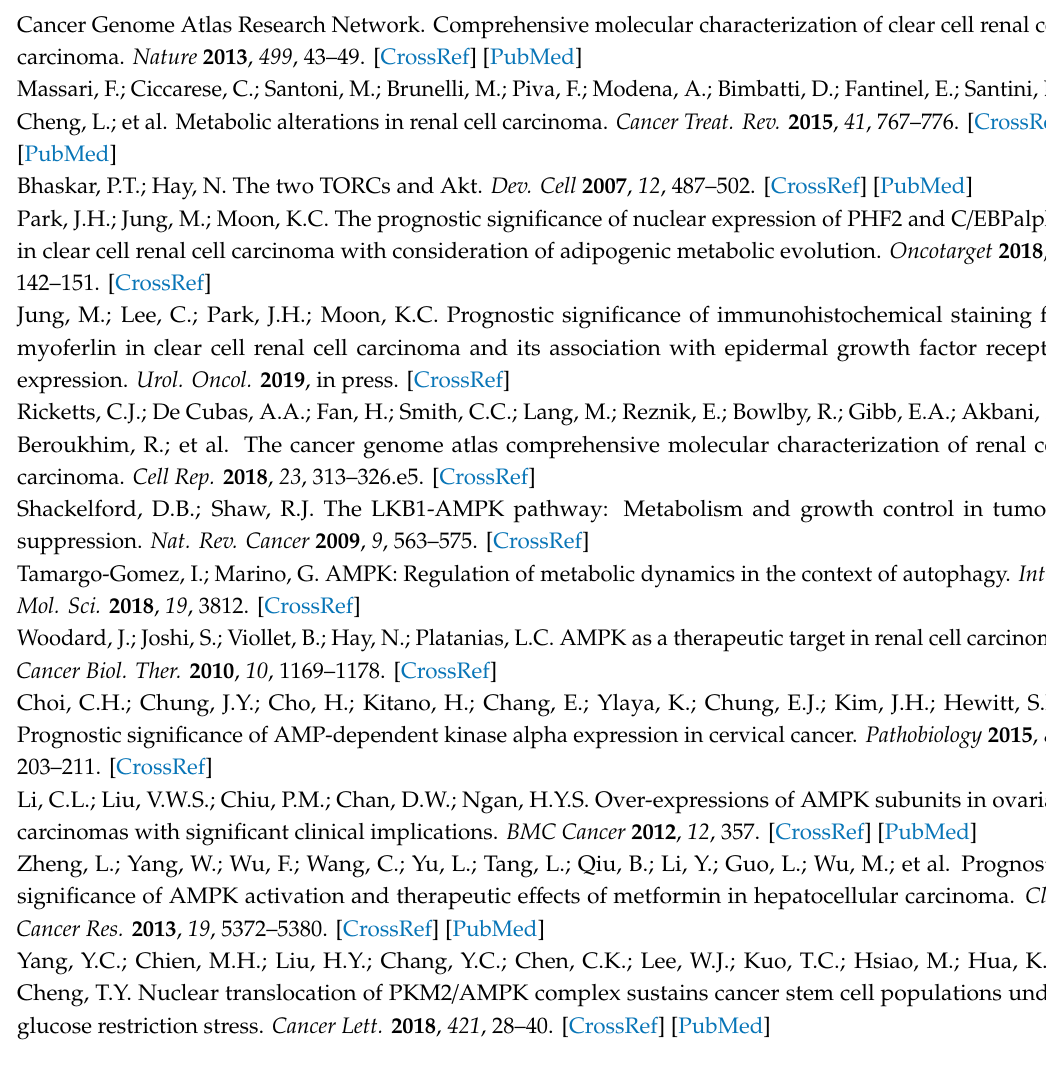
Figure S1: Establishment of the cut-o ff criteria for pAMPK